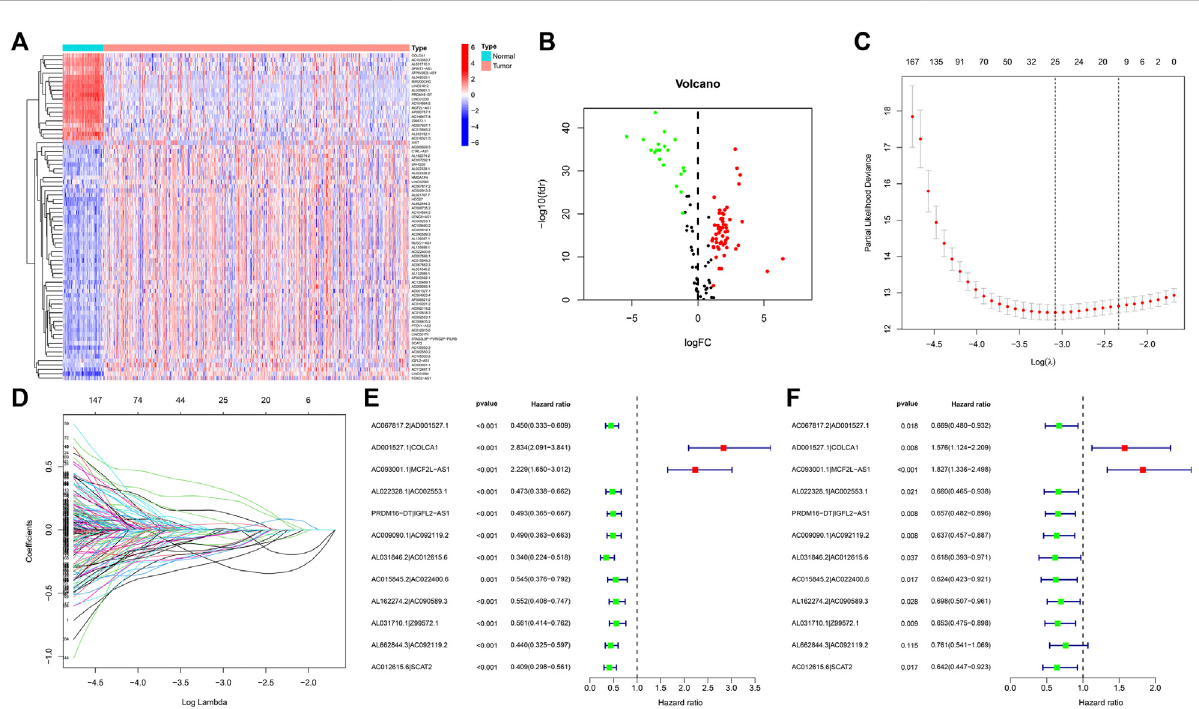
FIGURE 2 DE analysis of lncRNAs associated with lipid metabolism in ccRCC. (A) Heatmap of differentially expressed lipid metabolism lncRNAs. The red color denotes upregulation, and blue color denotes downregulation. (B) Volcanic map of differentially expressed lipid metabolism lncRNAs. Red dots: upward regulation with remarkable differential expression; green dots: downward regulation with remarkable differential expression; black dots:noremarkablediversity. (C) ElucidationofLASSOcoef fi cientpro fl ingofthoseprognosis-relatedlipidmetabolismlncRNAs. (D) Veri fi cation of tuning parameter selection for LASSO regressive model. (E) Univariable cox regressive analysis of the aberrantly regulated lipid metabolism- associated lncRNAs which might remarkably in fl uence the OS of ccRCC sufferers. Red: risky factor; Green: protection factor. (F) Multivariable Cox regressive analysis of promising prognosis lipid metabolism-associated